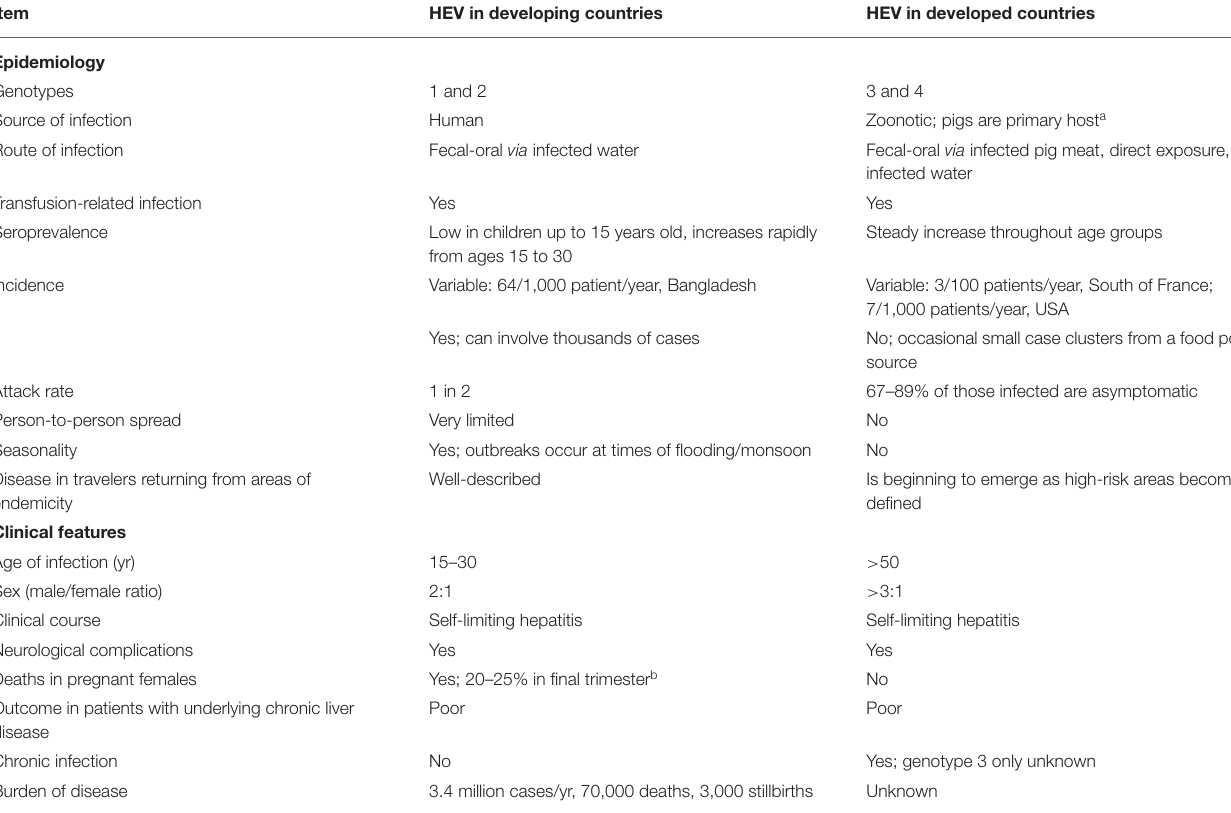
TABLE 2 | Epidemiology and clinical features of HEV infection in developing and developed countries.